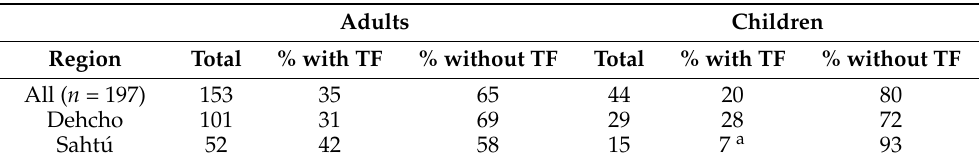
Table 3. Consumption of traditional foods (%) by region for adults and children; Mackenzie Valley Project 2016–2018, n = 197.